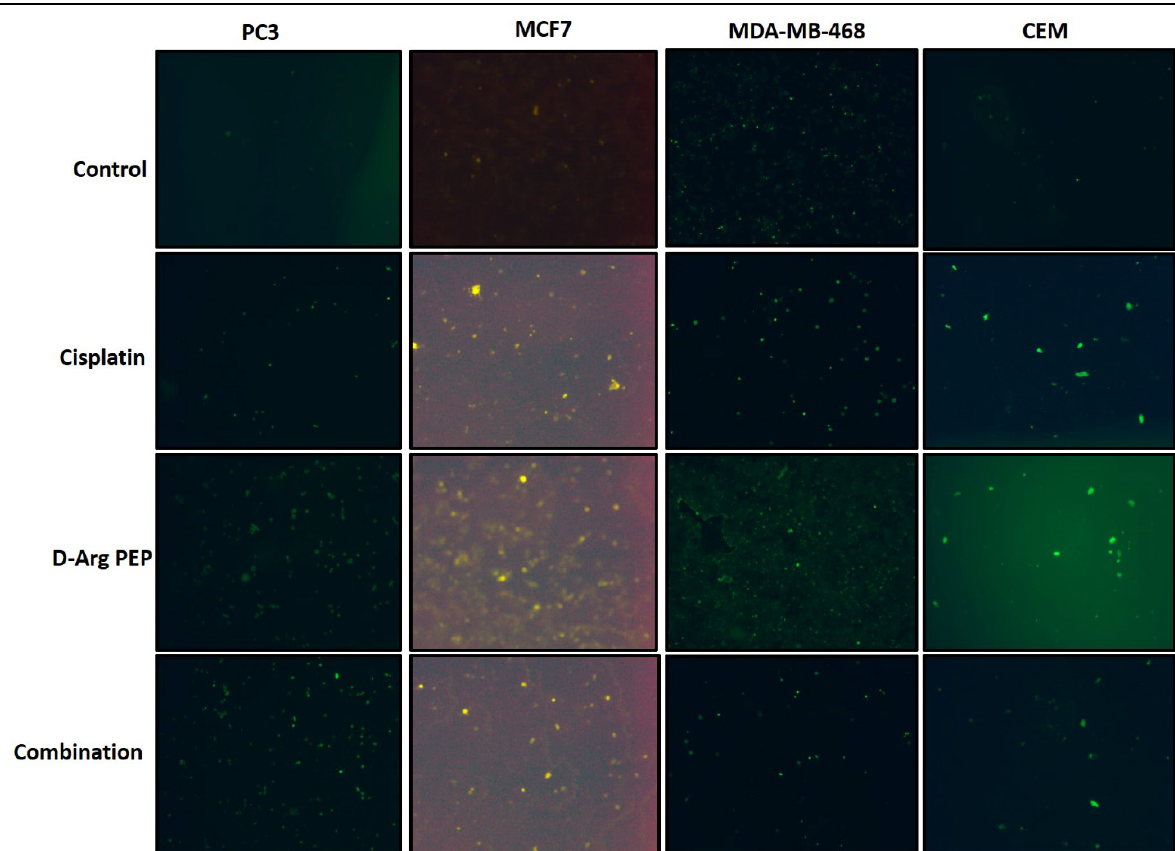
Figure 4. D-Arg PEP causes DNA damage. A synergistic effect in combination with cisplatin against the prostate cancer, breast cancer, and lymphoma cell lines is shown in Figures 2 and 3. Immunofluorescence pictures of cells showing a FITC- γ -H2AX signal after 48 h treatment of cells with IC 50 concentrations of D-Arg PEP or cisplatin or the combination compared to the untreated control. Nikon TE2000-U Fluorescence Microscope-AV (from the Rutgers Cancer Institute of New Jersey core facility) using 10X magnification was used to capture the images. It should be noted that the MCF7 and CEM cells showed a strong γ -H2AX signal that corresponds with their lower IC 50 for D-Arg PEP.